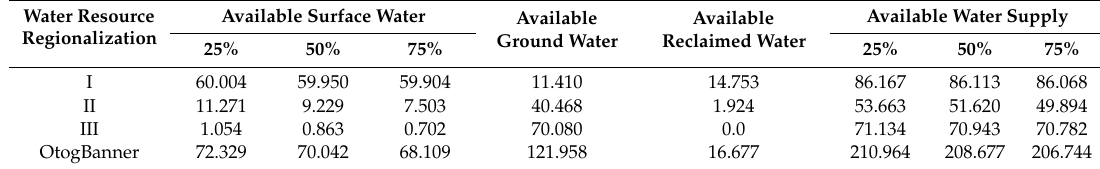
Table 1. The results of the currently available water supply in OtogBanner (10 6 m 3 ).